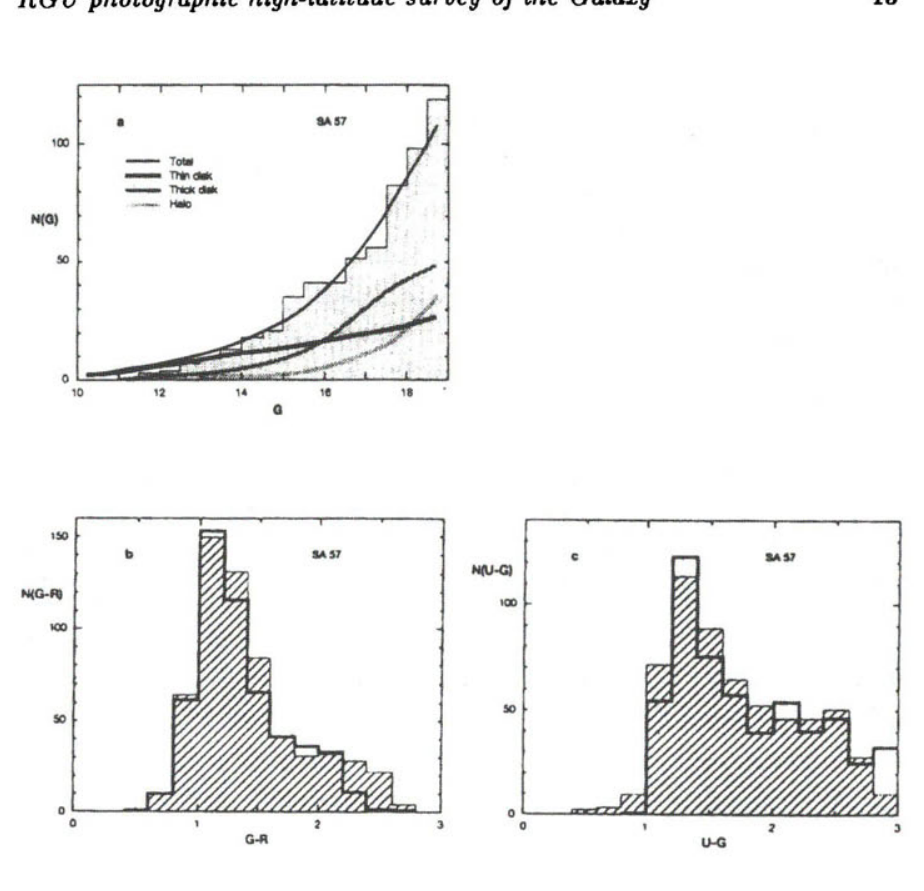
Fig. 7. Star counts and color distributions in SA 57. (a) Observed star counts as a function of apparent G magnitude (histogram) compared with the model counts (lines). The contributions from the individual population components show that the thick disk dominates the counts at the faintest survey magnitudes, mc > 16 mag. (b) and (c) Total observed (thin-lined histogram) and calculated (thick-lined histogram) color distributions in G-R and U-G,